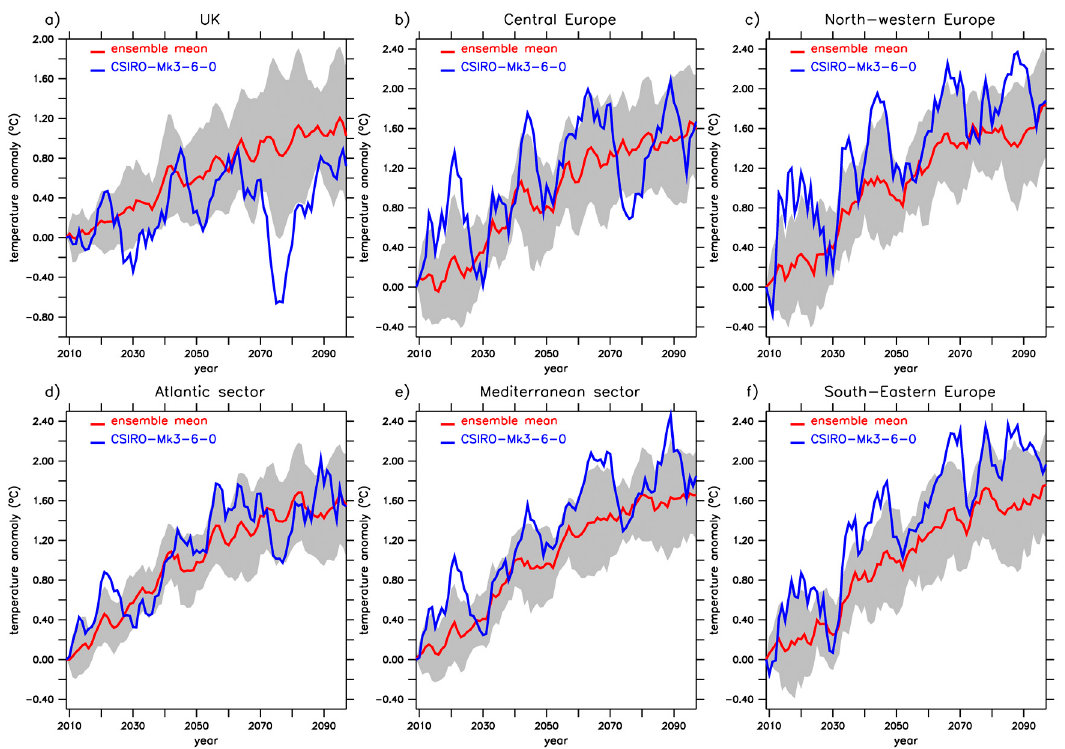
Figure 2. Evolution of the 2 m air temperature for the 21st century RCP4.5 projections over di ff erent regions of Europe: ( a ) The U.K., ( b ) Central Europe, ( c ) North-eastern Europe, ( d ) Atlantic sector, ( e ) Mediterranean sector, and ( f ) South-eastern Europe. Blue lines indicate the temperature evolution simulated with the CSIRO-Mk3-6-0 model. Red lines indicate the seven downscaled models ensemble mean temperature evolution, which is embedded in the grey portion indicating the inter-model spread, i.e., the standard deviation.